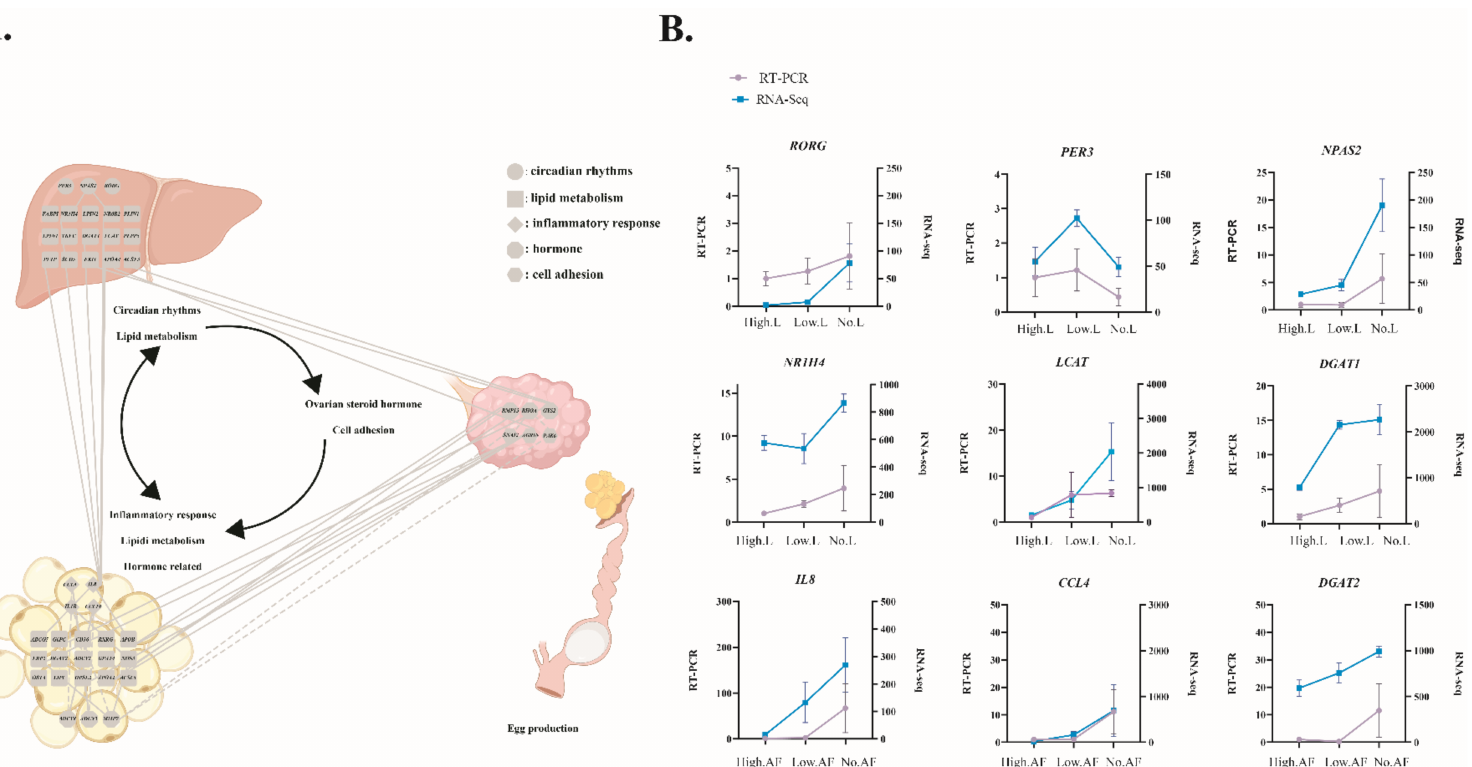
Figure 4. The network of liver, abdominal fat, and ovarian stroma regulating laying performance in geese and the expression validation of hub genes. The network of L–AF–O (liver, abdominal fat, ovarian stroma) regulating laying performance in geese ( A ). qRT-PCR validation of expression of the main DEGs involving the network of egg production performance regulation by liver, abdominal fat, and ovarian stroma ( B ). The results of qRT-PCR and RNA-Seq were expressed as the mean ± SD (n = 3, three biological replications at each group). “AF” means abdominal fat, “L” means